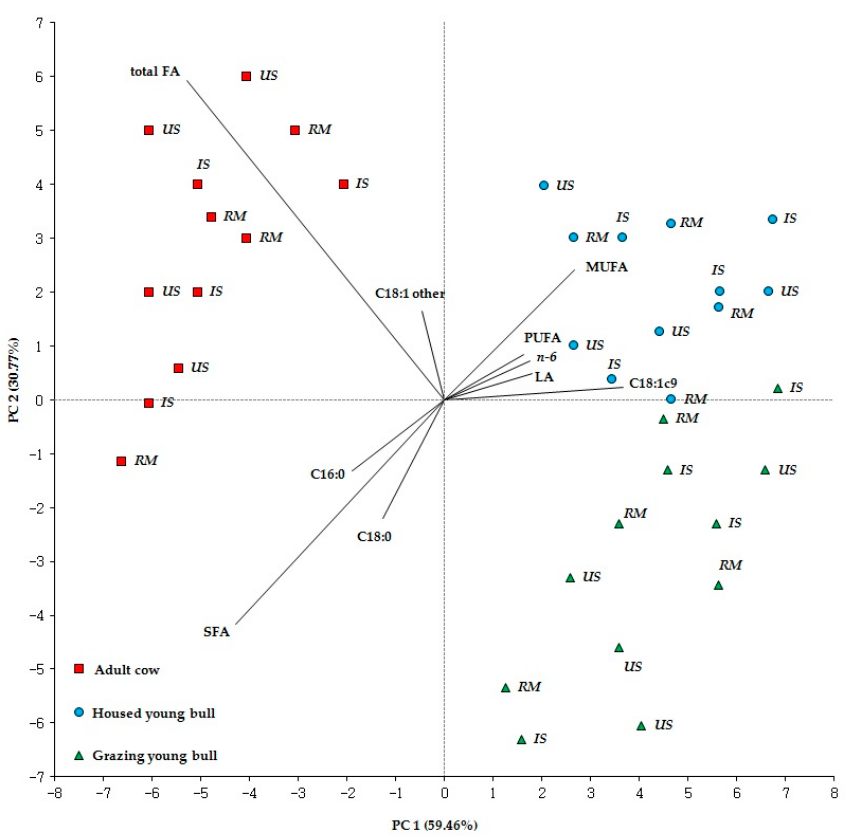
Figure 1. Score plot and loading plot from principal component analysis (PCA) of raw mixture and ripened salami. Ab- breviations: RM = raw mixture; IS = inoculated salami; US = uninoculated salami; SFA = saturated fatty acids; MUFA = monounsaturated fatty acids; PUFA = polyunsaturated fatty acids; LA = linoleic